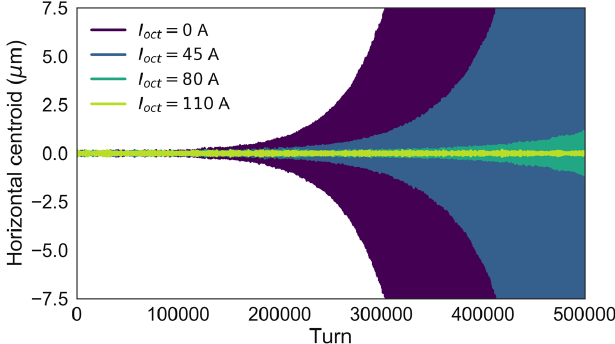
FIG. 7. Horizontal bunch centroid signals over the full P y HEAD- TAIL simulation period for a selection of four different Landau octupole currents for the single-bunch head-tail instability ob- served in the LHC at 6.5 TeV.